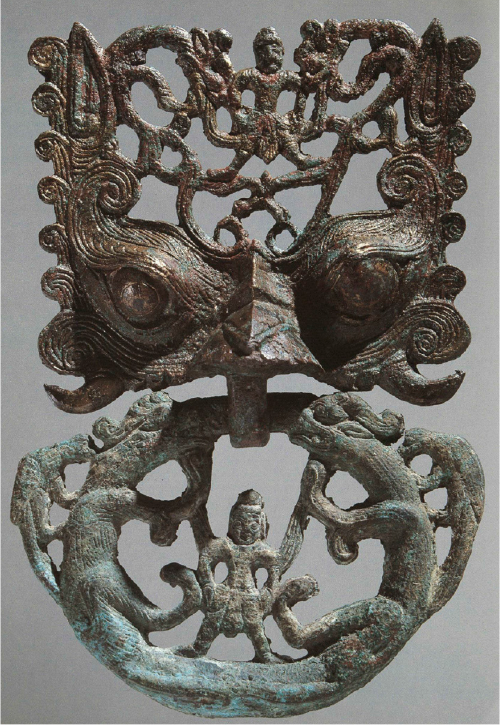
Figure 13. Pushou with human–animal juxtaposition, gilt bronze, excavated from Tomb of Feng Shigong, Guyuan, Ningxia Autonomous Region. 486 CE; after (Juliano et al. 2001, cat. 17).